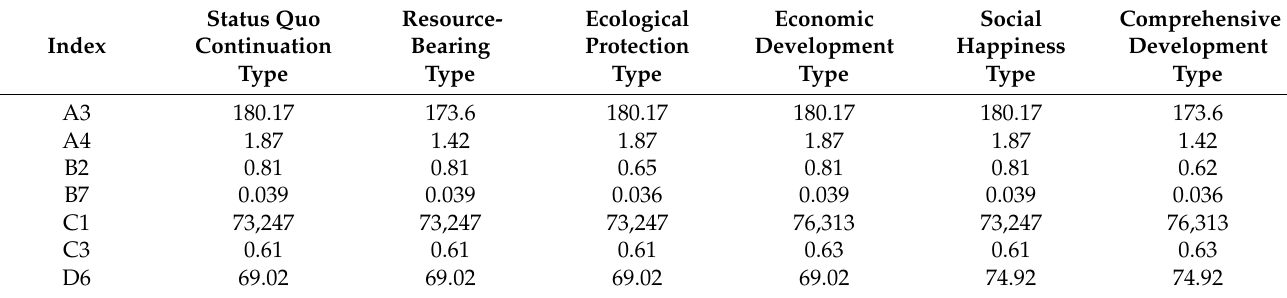
Table 6. The values of key constraints under each type in 2025.